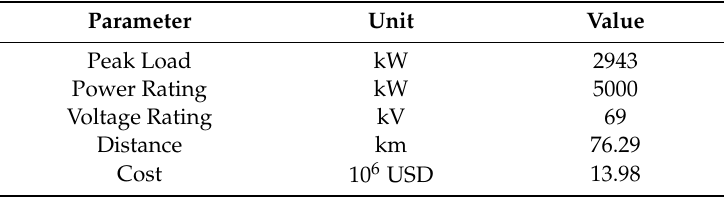
Table 7. Summary of interconnection scheme of the four-island